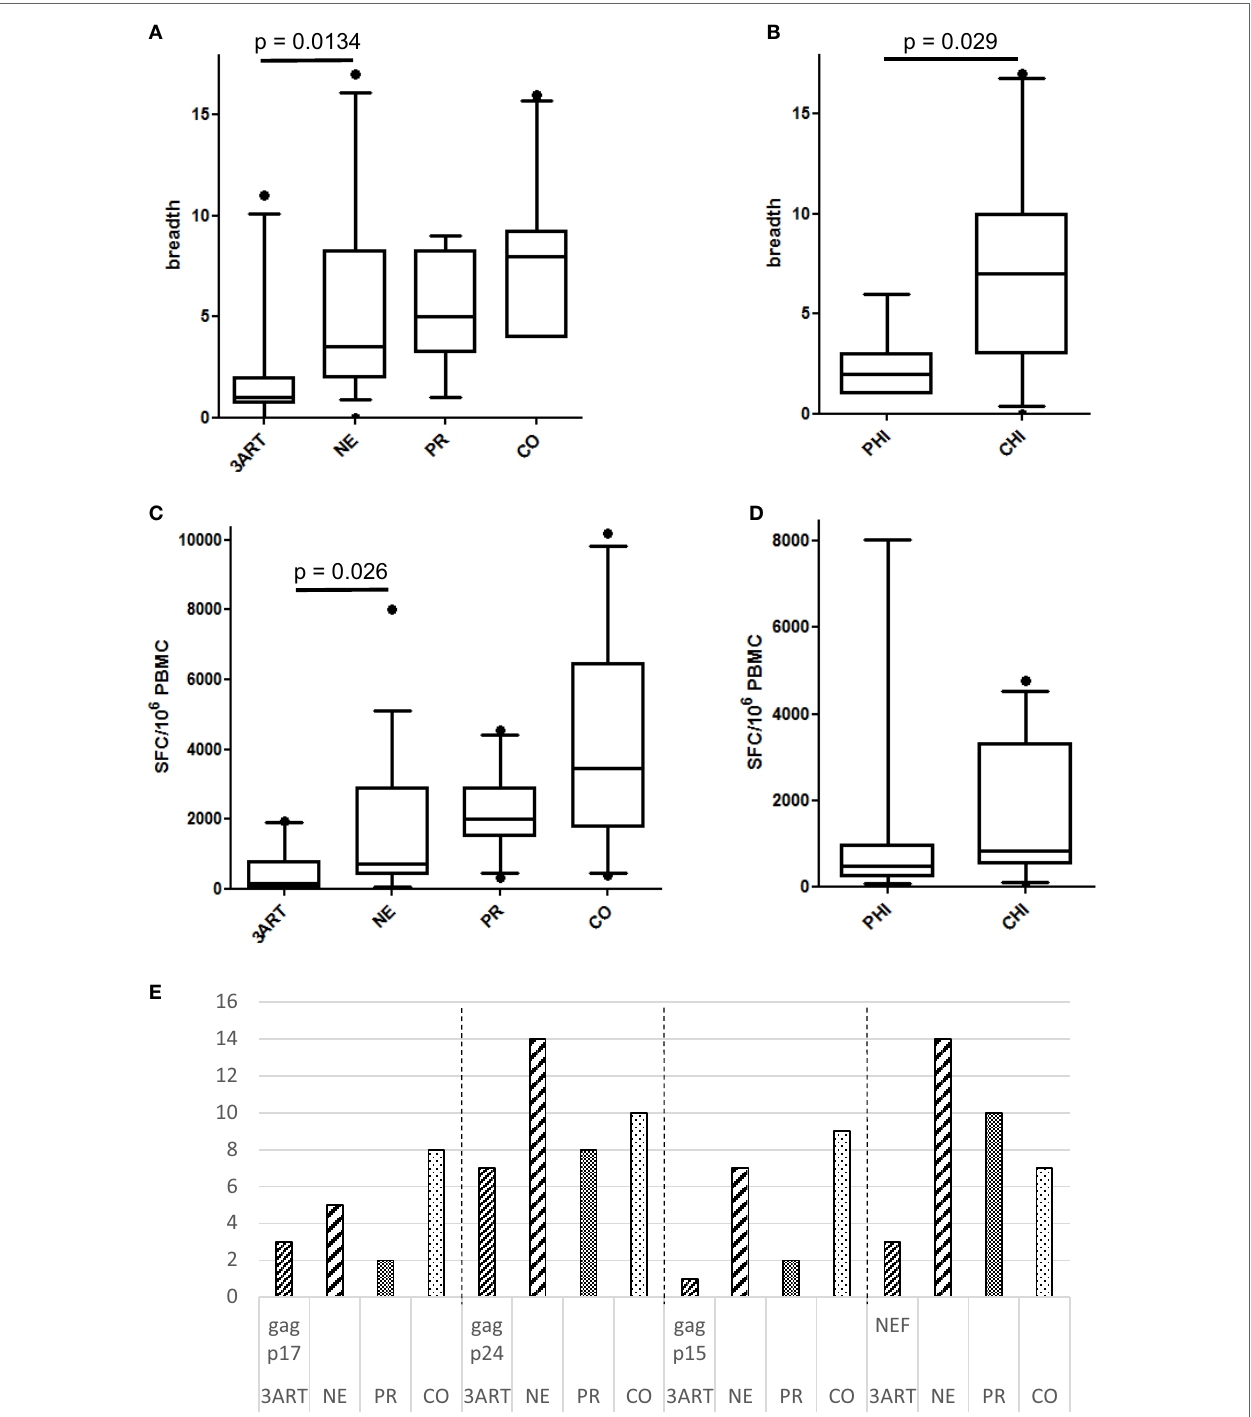
FigUre 5 | (a) Breadth of immune responses in the New Era (NE) and control groups. The NE patients had significantly more CD8 T cell responses in Gag and Nef than the 3ART patients ( p = 0.0134). (B) The chronic HIV infection (CHI) subgroup showed a significantly higher breadth of immune responses than the primary HIV infection (PHI) subgroup ( p = 0.029). (c) The magnitude of the NE group was significantly higher than in the 3ART patients ( p = 0.026). (D) There was no difference between the PHI and CHI subgroups, with regard to the magnitude of the CD8 T cell response ( p = 0.28). (e) Gag p17 and Gag p15 were more often recognized by the NE (especially CHI) and CO groups than by the progressor (PR) and 3ART groups. Spot-forming cells (SFC)/10 6 peripheral blood mononuclear cells (PBMCs). For the magnitude of the CD8 T cell response, all the individual CD8 T cell responses within Gag and Nef were added for each patient [3ART: n = 10; NE: n = 18 (PHI: n = 7; CHI: n = 11); PR: n = 10; CO: n =